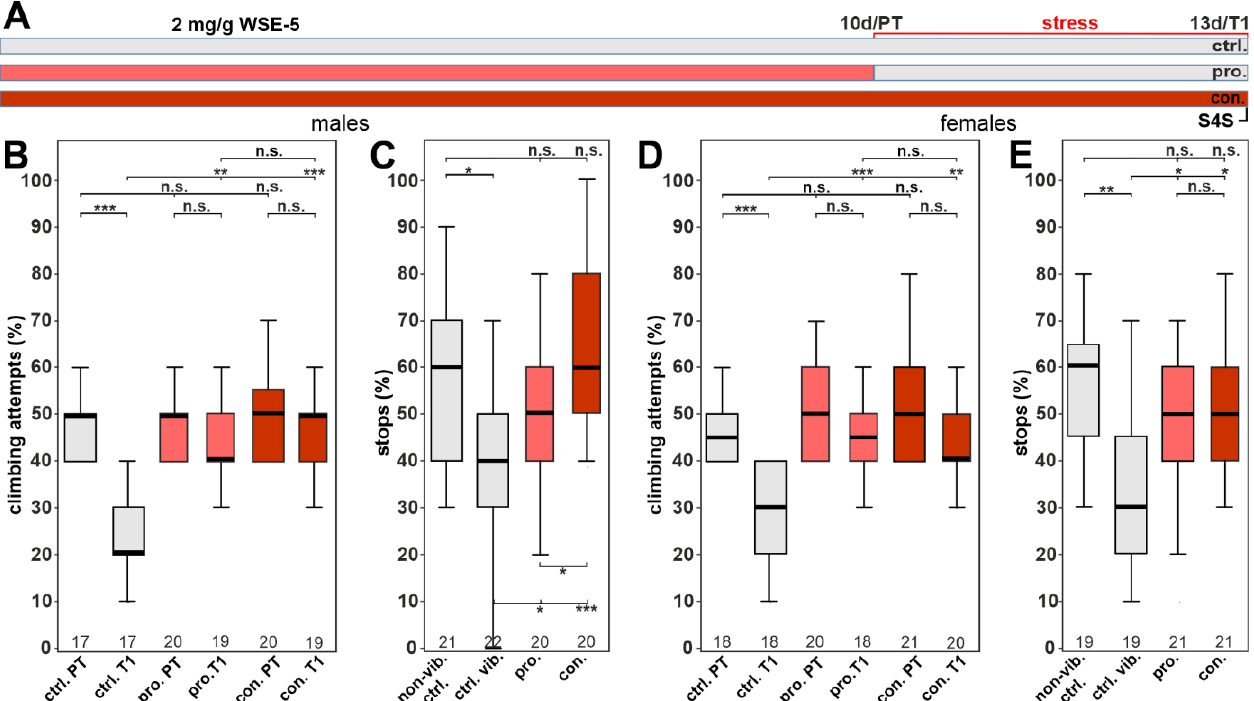
Figure 9. WSE-5 protects against stress-induced behavioral phenotypes at 2.0 mg/g. ( A ) Schematic of the treatment paradigm (the time of WSE-5 treatment is indicated in red). ( B ) Percent of climbing attempts of males before (PT) and after stress (T1) was applied. ( C ) Number of stops males made at the sweet-tasting stripe. ( D ) Percent of climbing attempts of females before and after stress was applied. ( E ) Number of stops females made at the sweet-tasting stripe. A pairwise Wilcoxon test with Bonferroni–Holm correction for multiple comparisons was used in each panel. The number of analyzed flies is given below the boxes. The horizontal bars in the box plots represent the medians, boxes the 25% and 75% quartiles, and whiskers the data points within ± 1.5 times the interquartile range (IQR). S4S = stop for sweet test, ctrl. = control, vib. ctrl = vibrated control, non-vib. ctrl. = nonvibrated control, pro. = prophylactic treatment, con. = continuous treatment. * p < 0.05, ** p < 0.01, *** p < 0.001, n.s. = not